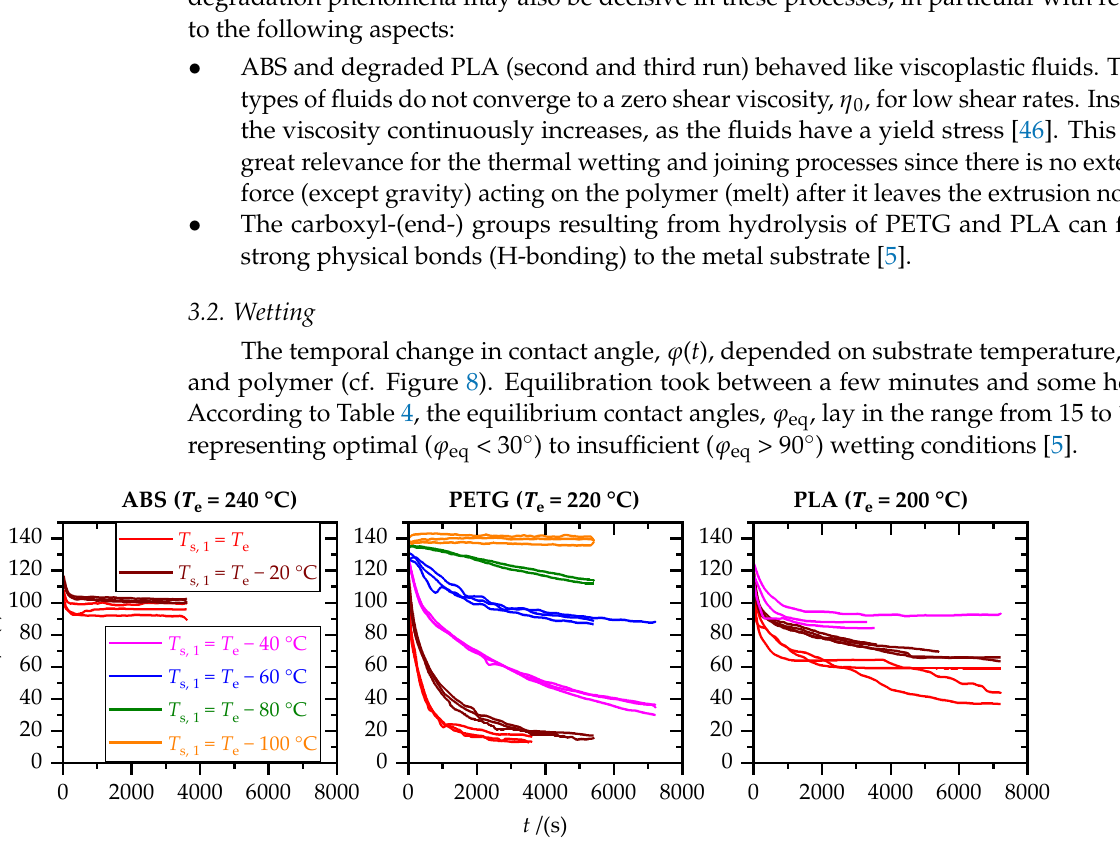
Figure 8. Contact angle, φ , between polymer drop and aluminum substrate as a function of wetting time, t , for several substrate temperatures, T s,1 .